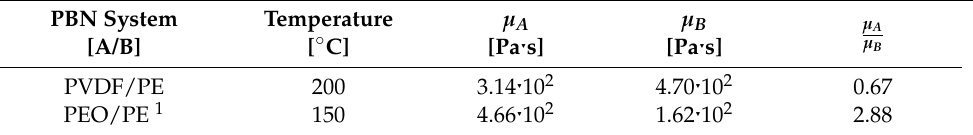
Table 3. Complex Viscosity Data of PVDF/PE and PEO/PE Systems